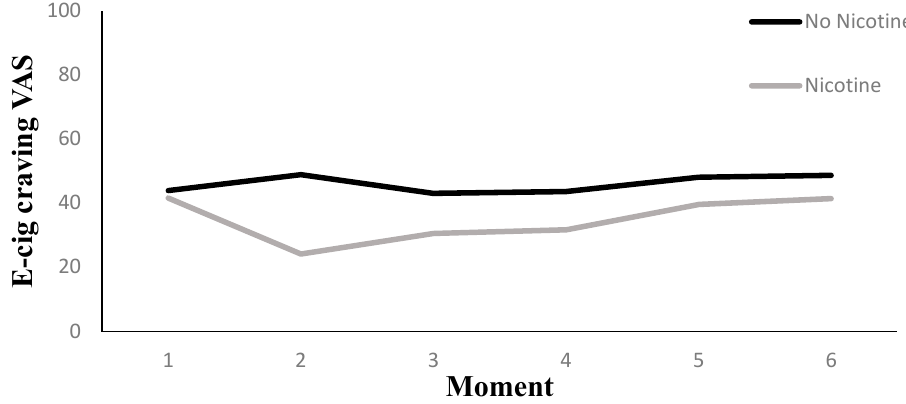
Figure 8. The interaction between moment and nicotine level in the visually unrestricted condition for e-cig craving.